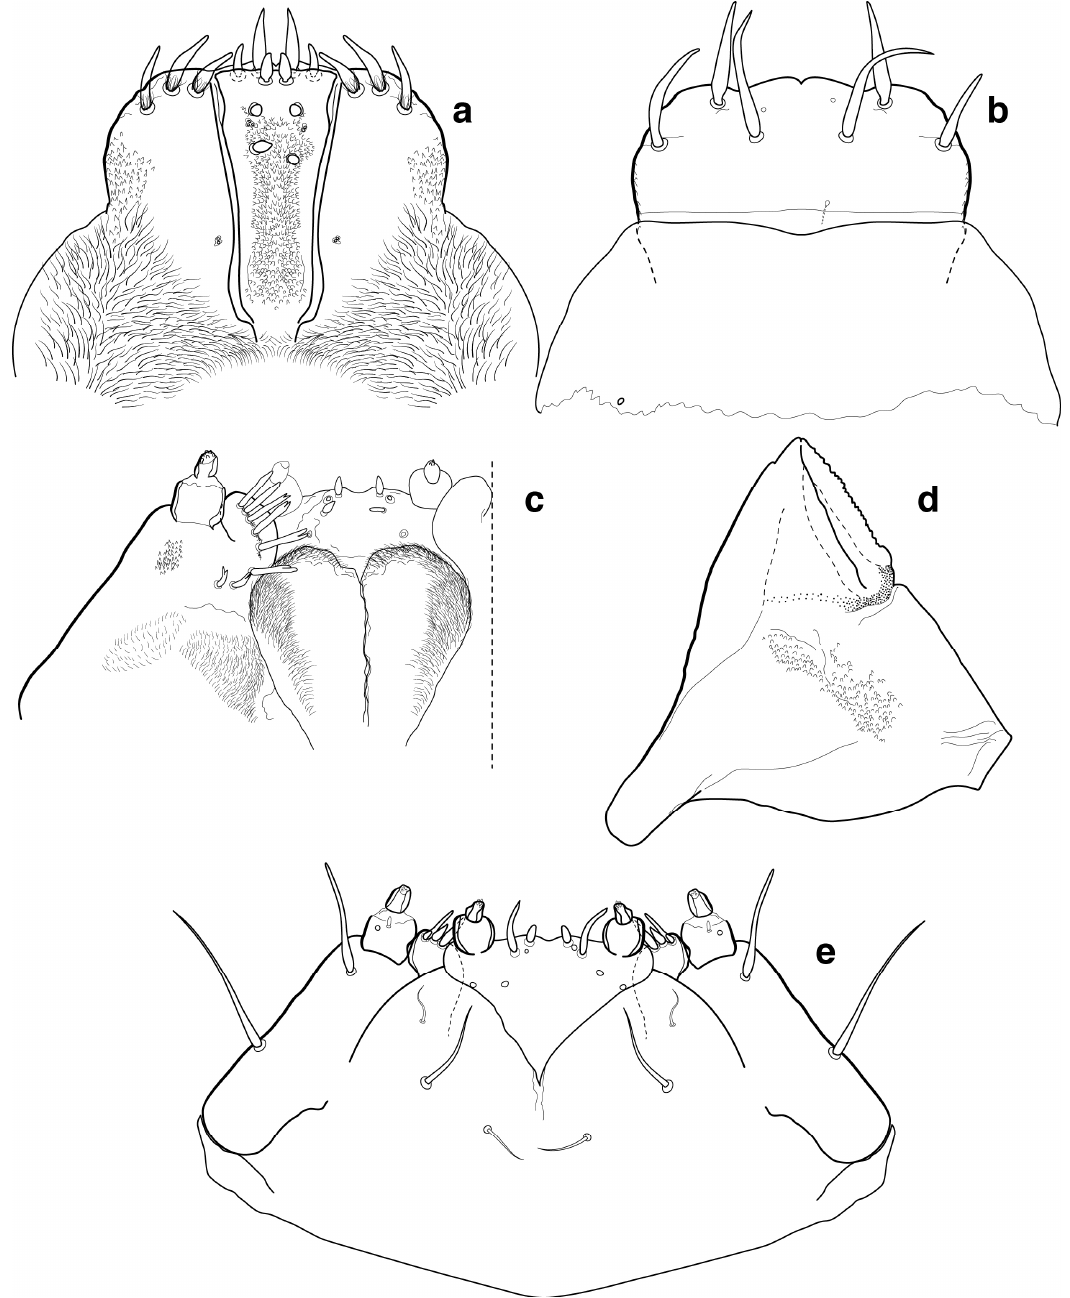
Figure 59. Diathetes morio mouthparts: ( a ) epipharynx; ( b ) clypeus (incomplete) and labrum; ( c ) detail of hypopharynx, mala, and maxillary palp, dorsal view; ( d ) mandible; and ( e ) labio-maxillary complex, ventral view.